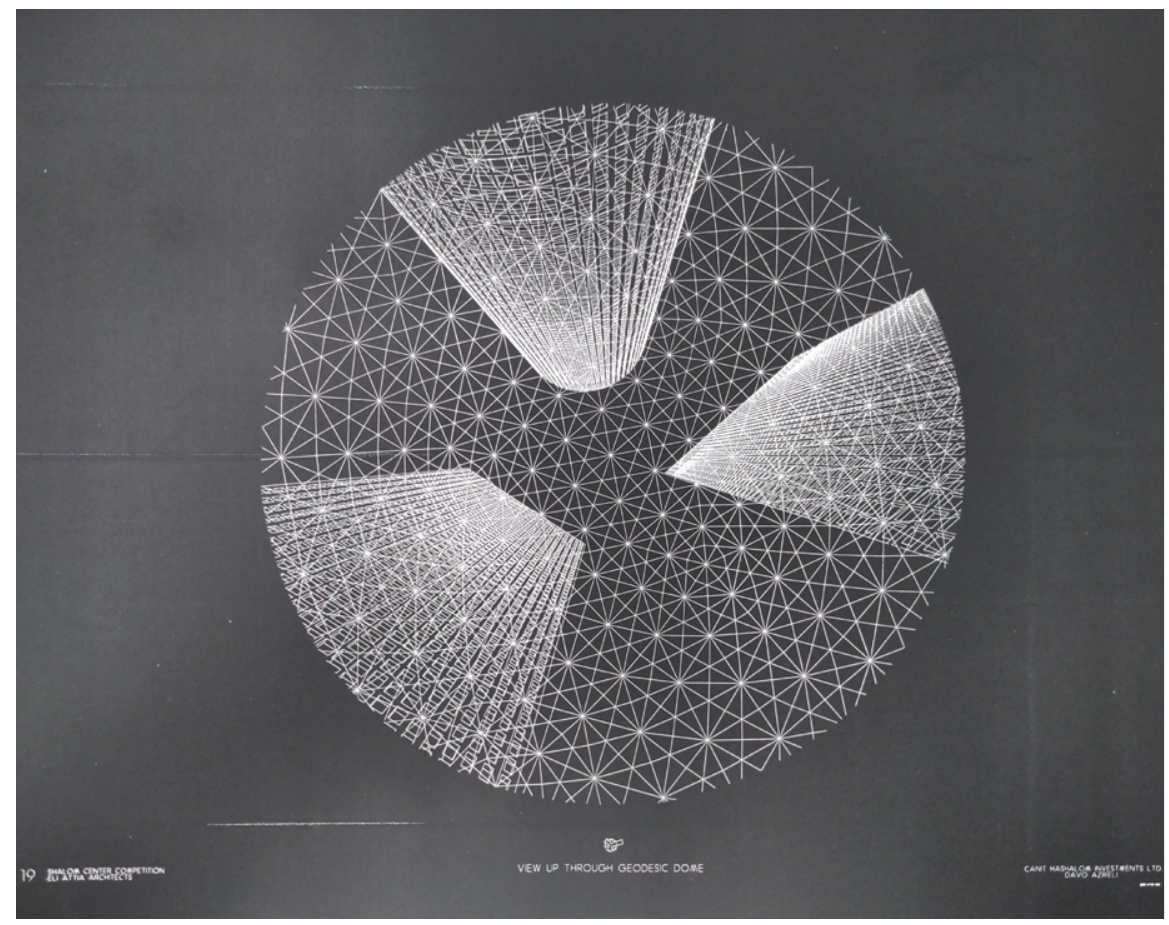
FIG. 2 Rendering showing the view from the mall’s indoor spaces towards the towers, as presented in the official design submission by architect Eli Atti [credits: Credits Eli Attie Architects and Tel Aviv Municipality